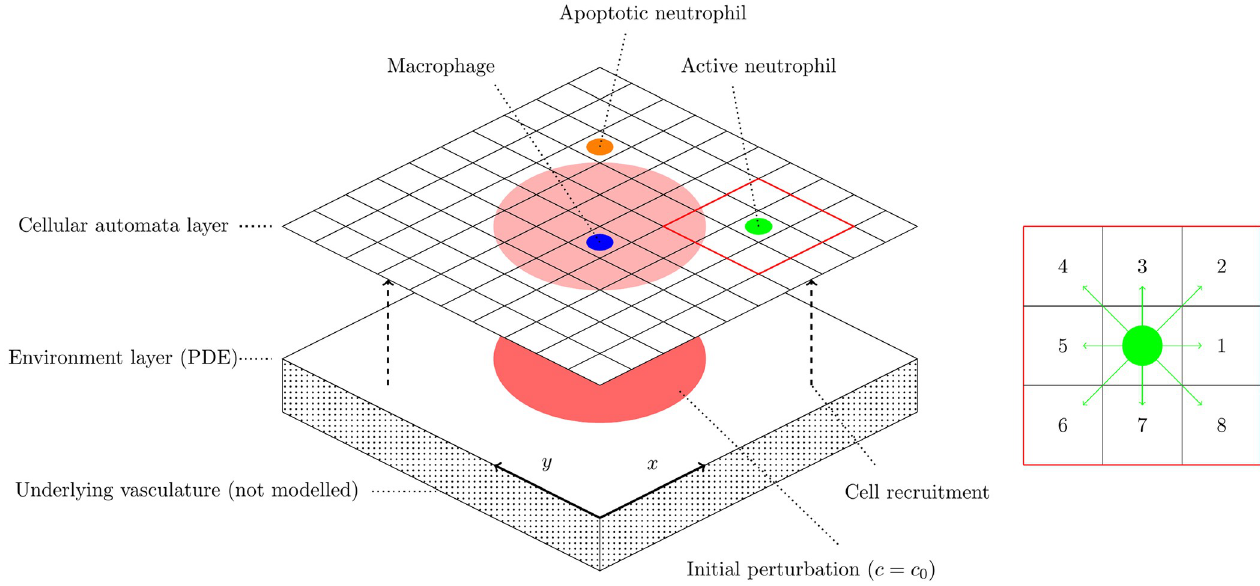
Fig 1. Schema of the spatial domain used in our simulations. Inset: the Moore neighbourhood of a generic cell, showing the indexing system used to number neighbouring grid spaces when defining and calibrating our model of cell chemotaxis.